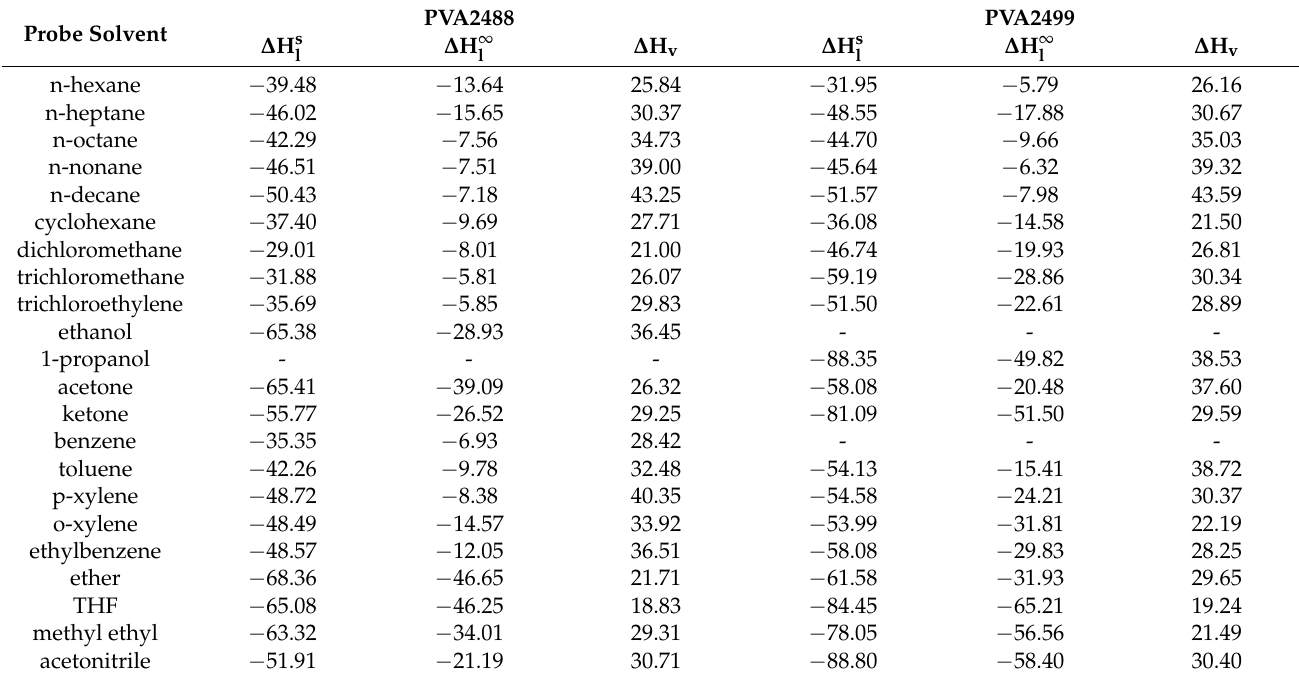
Table 3. Thermodynamic parameters of the probe solvent (KJ/mol).